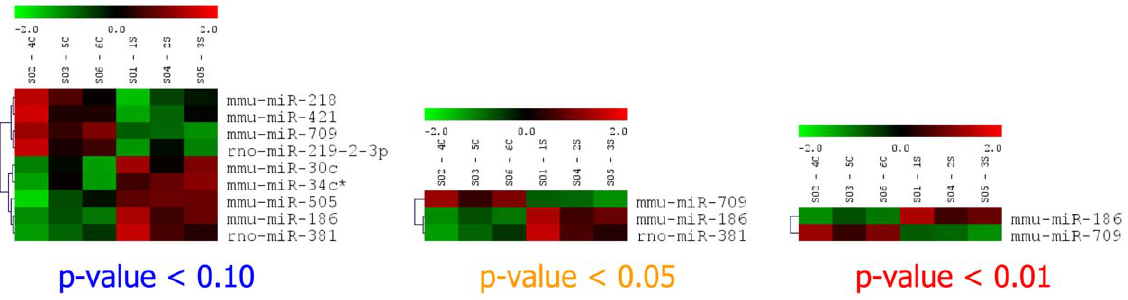
Figure 8. Analysis of miRNA expression in the rat cerebellum after two weeks of stress compared to controls. The microarray heatmap demonstrates the log 2 ratio of miRNA signal difference between control and stress samples. Up-regulated miRNAs are shown in red, while down- regulated miRNAs are shown in green. The first three columns on each figure represent the level of expression in control animals, while the three last columns represent the level of corresponding miRNA expression in stress animals.